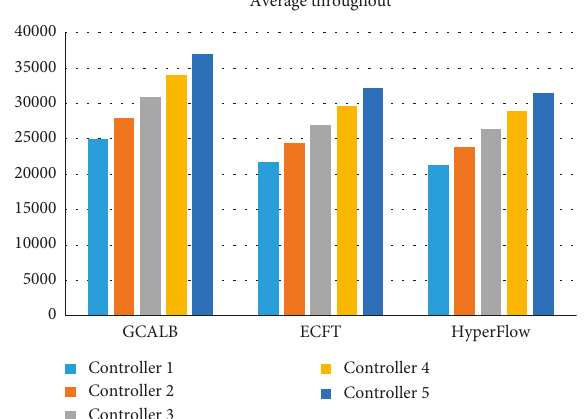
Figure 18: Comparison among average throughputs for GCALB, ECFT, and HyperFlow for five slave controller model.